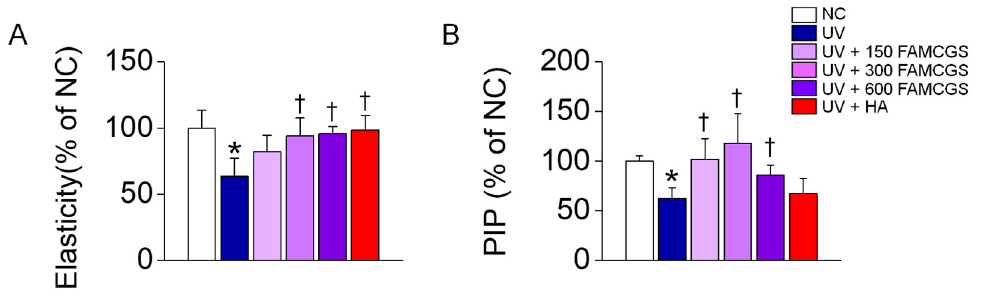
Figure 6. Effect of FAMCGSs on dermal elasticity. ( A ) Skin elasticity ( B ) Content of procollagen Type I C-peptide (PIP). Each bar represents the mean ± SD ( n = 5 in each group). * p < 0.05 compared to the NC group. † p < 0.05 compared to the UV group.